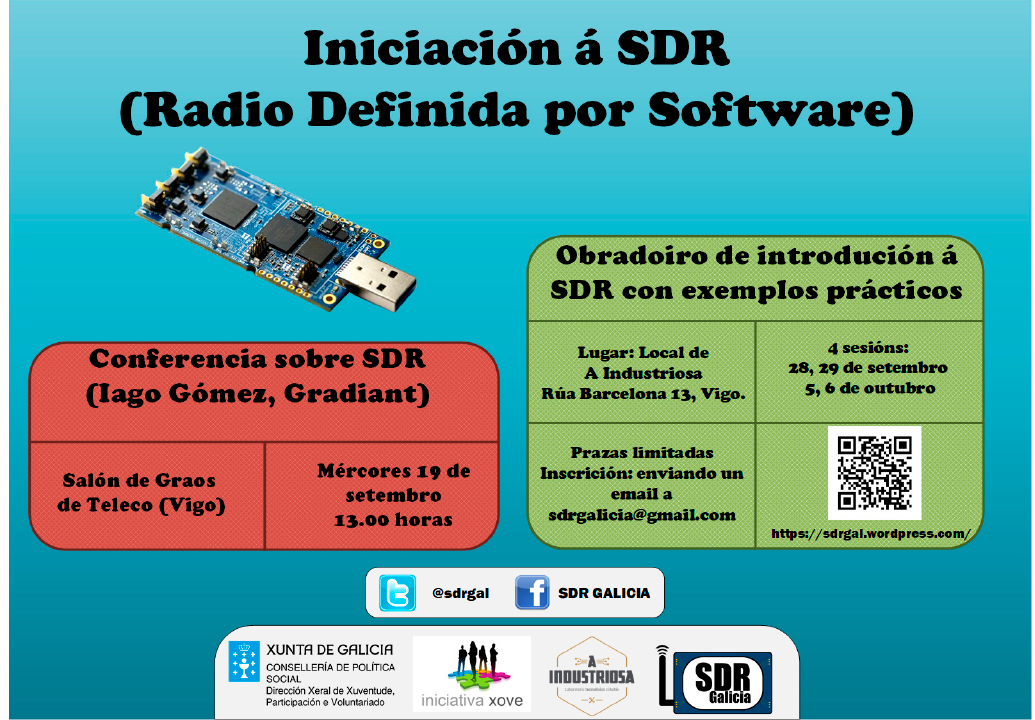
Figure 3. Poster of the dissemination activities related with